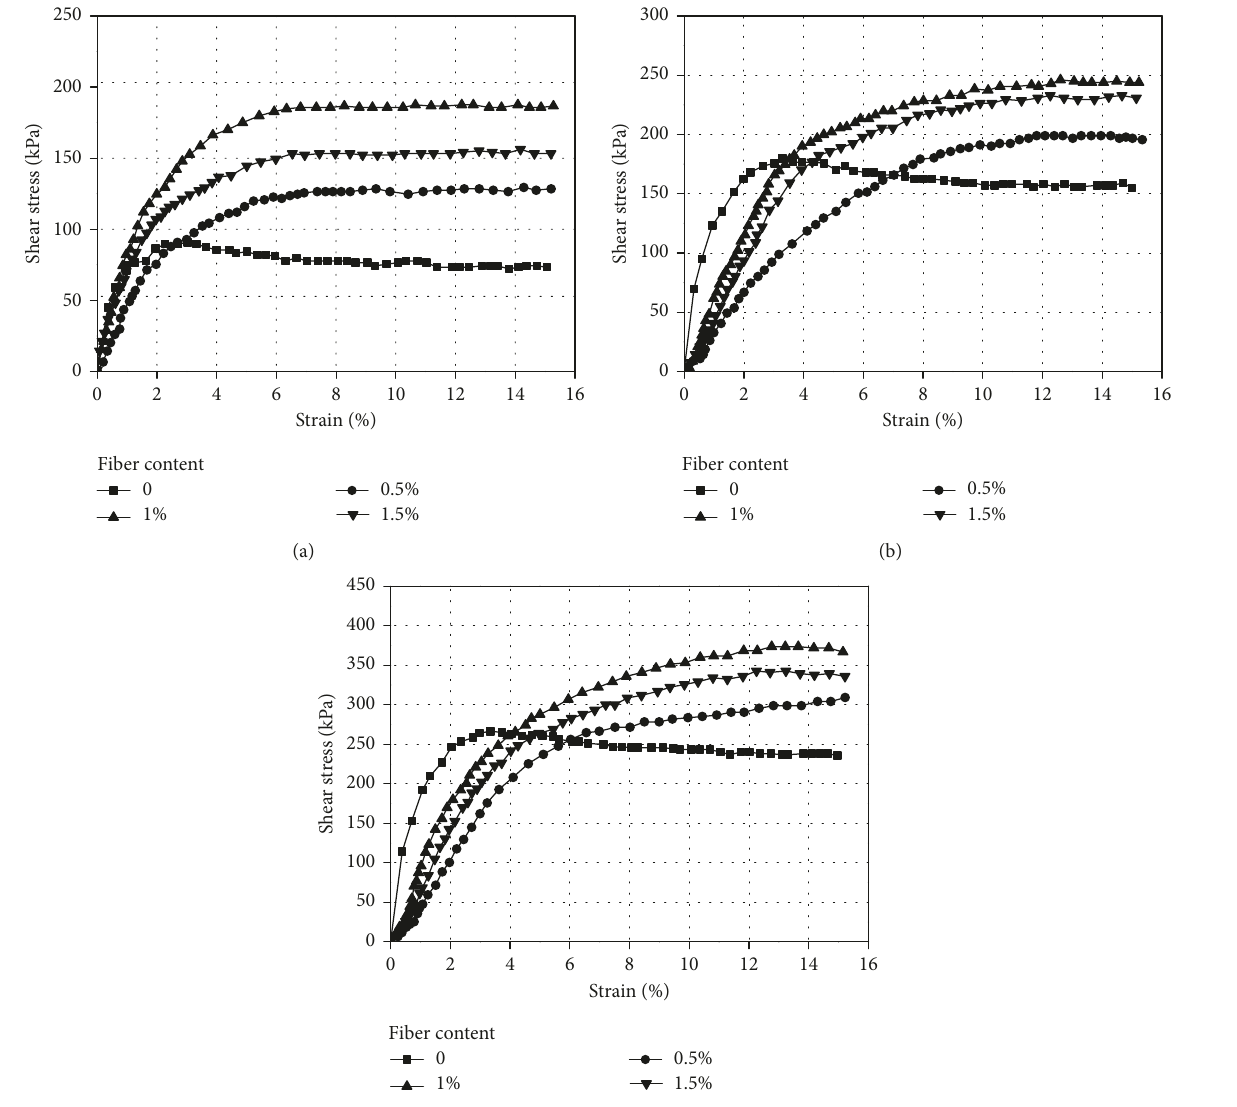
n (cid:31) 100kPa, (b)